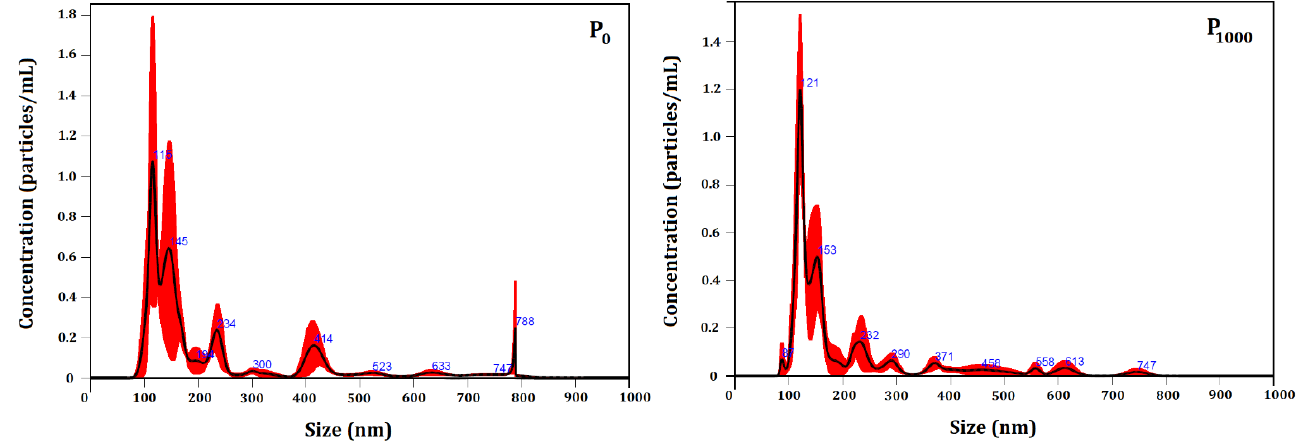
Figure 5. NTA particle size distribution analysis of P 0 and P 1000 systems. Representative histograms of the average size distribution (black line) from three measurements of a single sample. Red areas specify the standard deviation (SD) between measurements, and blue numbers indicate the maxima of individual peaks.